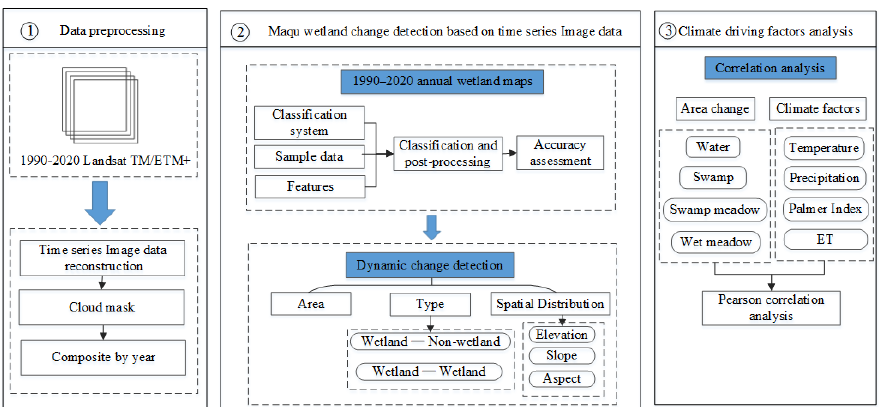
Figure 2. Flowchart of the long-term time series wetland change detection and analysis of the driving climate forces.